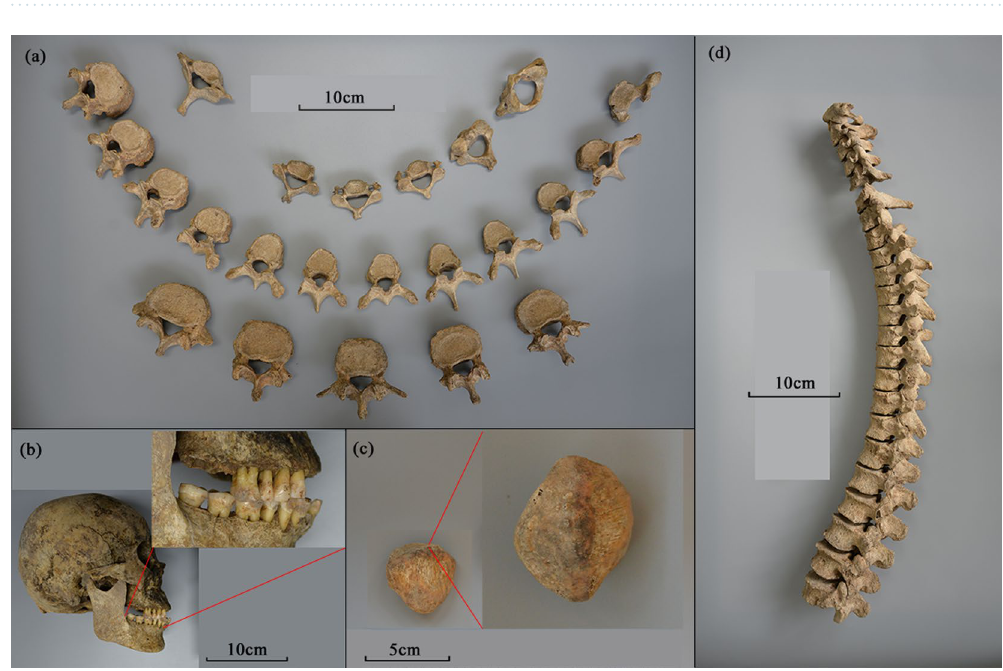
Figure 3. The pathological conditions of this individual: ( a ) Marginal osteophytes on vertebral columns; ( b ) Roots exposure and alveolar resorption indicative of periodontal disease; ( c ) Marginal osteophytes and bone spurs on the right patella; ( d ) Abnormal vertebral curvature. Note: C6 was